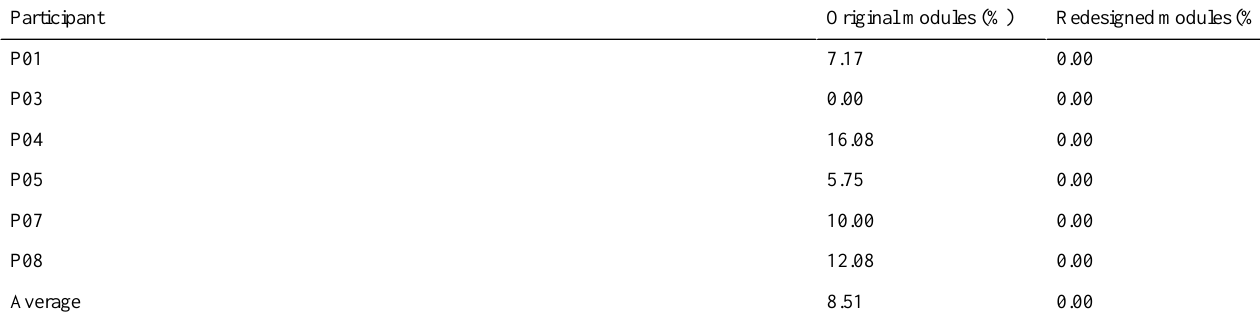
Table 6. Comparison of the error rates.